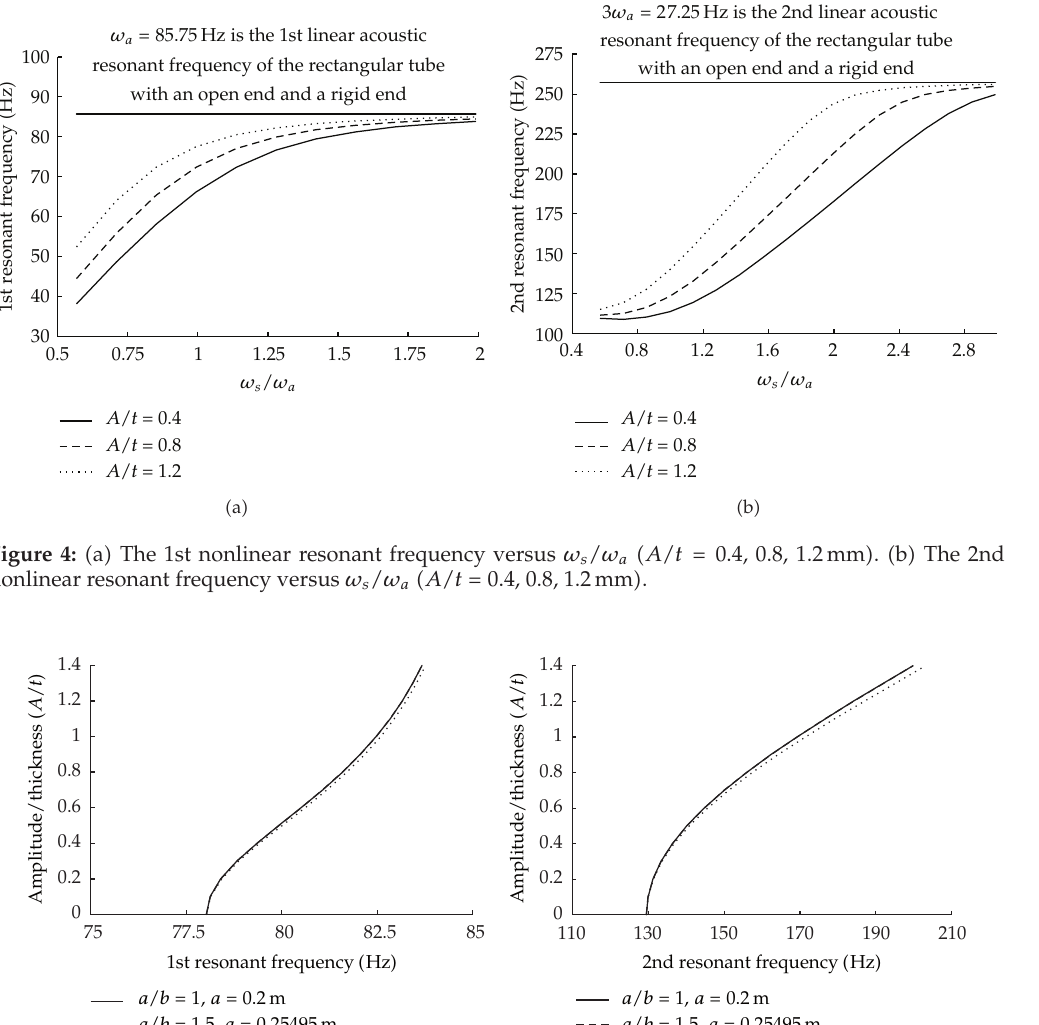
panel is lower than the linear 1st acoustic resonant frequency; (cid:3) 2 (cid:6) if the linear 1st structural resonant frequency of the panel is lower than the linear 1st acoustic resonant frequency of the tube with one rigid end, the 2nd nonlinear resonant frequency of the structural-acoustic system is less sensitive to the panel thickness for small amplitude ratio, and more sensitive for large amplitude ratio; and (cid:3) 3 (cid:6) in each case considered, the 1st nonlinear resonant frequency is always lower than the linear 1st acoustic resonant frequency, and the 2nd nonlinear resonant frequency is always higher than the 1st linear acoustic resonant frequency and lower than 2nd linear acoustic resonant frequency,